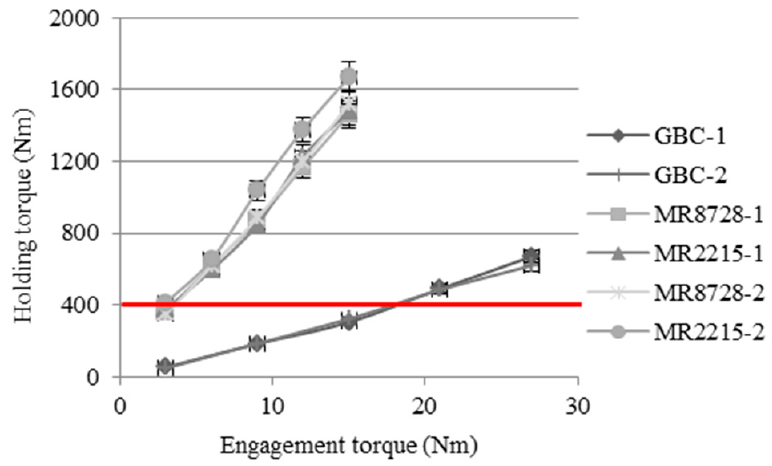
Figure 10. Engagement torque versus quasi-static holding torque for various friction materials.